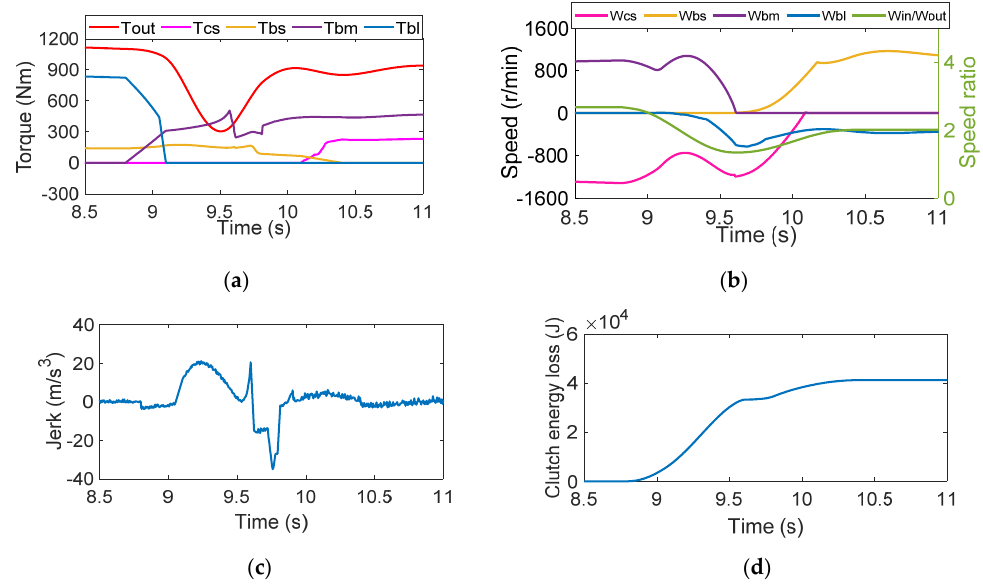
Figure 5. Simulation results of 2–3 power-on double-transition upshift for Strategy 1. ( a ) Output shaft and clutch torque. ( b ) Clutch speed and speed ratio. ( c ) The jerk of shift process. ( d ) The clutch energy loss of shift process.